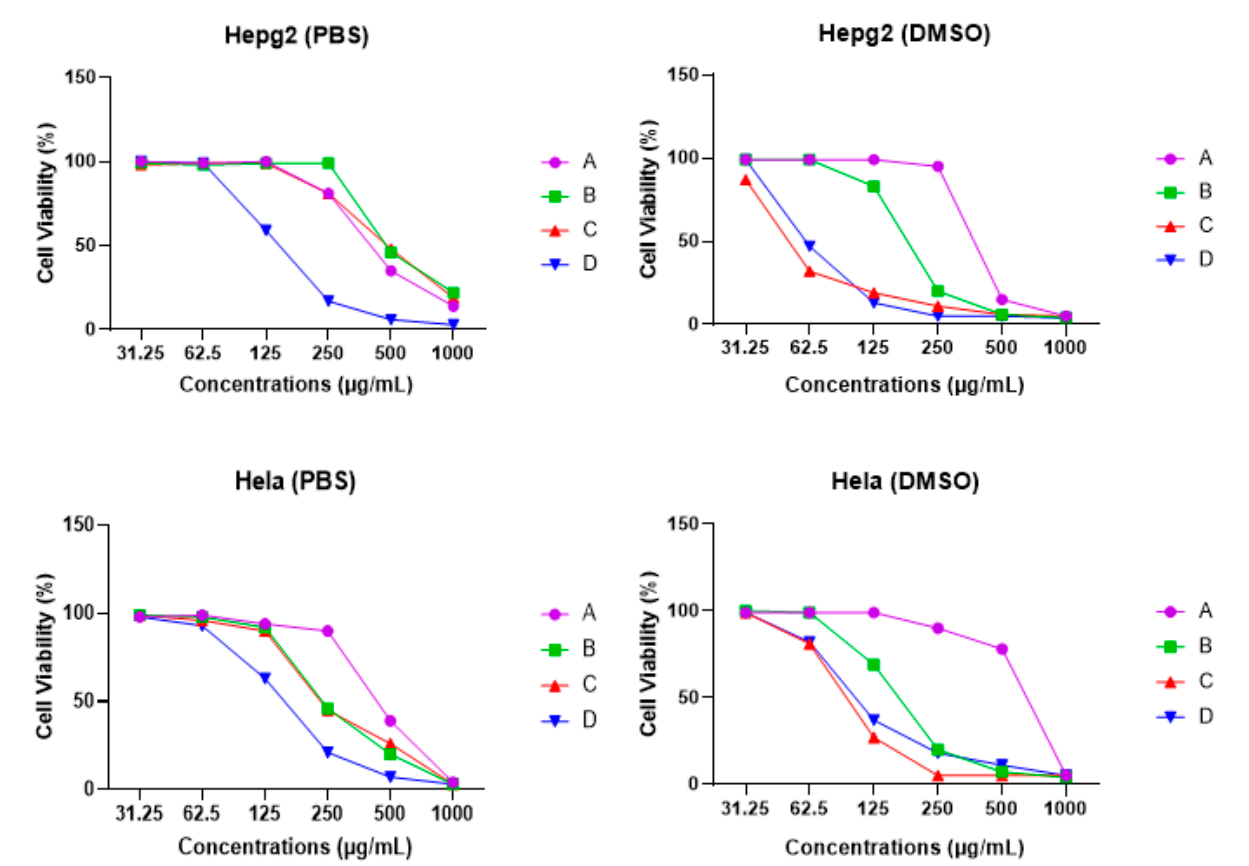
Figure 3. E ff ects of honey bee hemolymph extracts dissolved at di ff erent concentrations in PBS or DMSO on human cancer cell proliferation (HepG2 and HeLa), where ( A ): bees from Port Said, ( B ): bees from Ismailia governorate, ( C ): bees from Suez governorate, ( D ): bees from Saint Catherine.